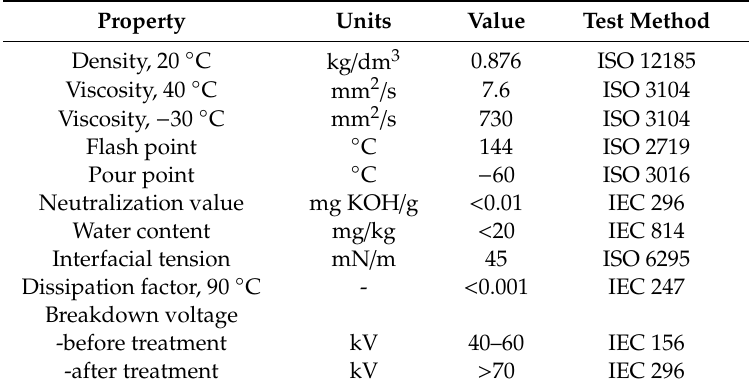
Table 2. Typical physical, chemical, and electrical properties of Nynas Nytro 10 × mineral oil. Data are from the o ffi cial Nynas data sheet, available online